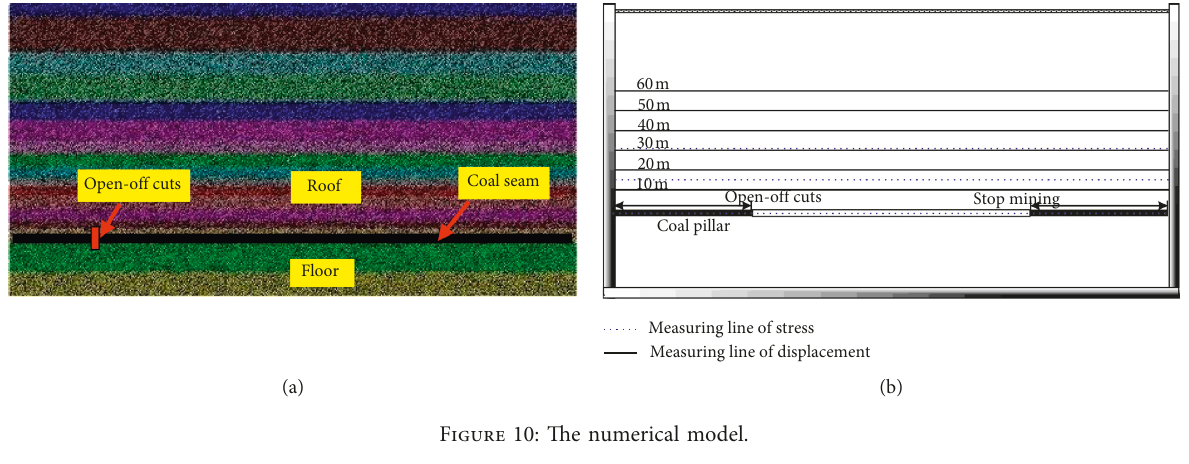
Figure 10: The numerical model.